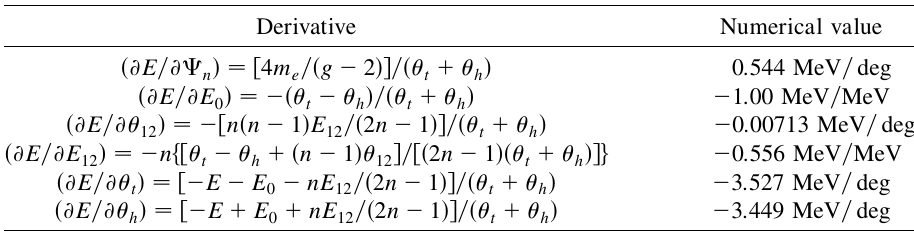
TABLE VII. The derivative of Eq. (6) with respect to each of the dependent parameters is shown alongside the corresponding the numerical value calculated for Hall B. The numerical values for Halls A and C are within 5% of the values for Hall B.